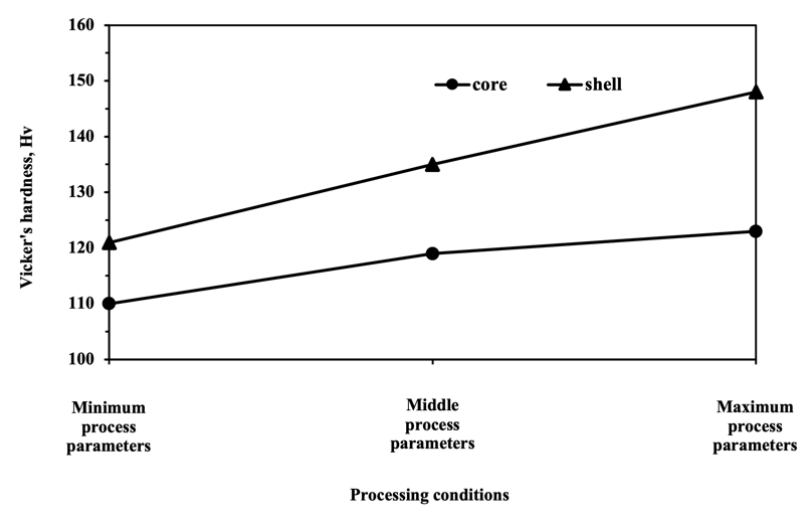
Figure 8. Plot of the hardness for the core and shell regions as a function of process